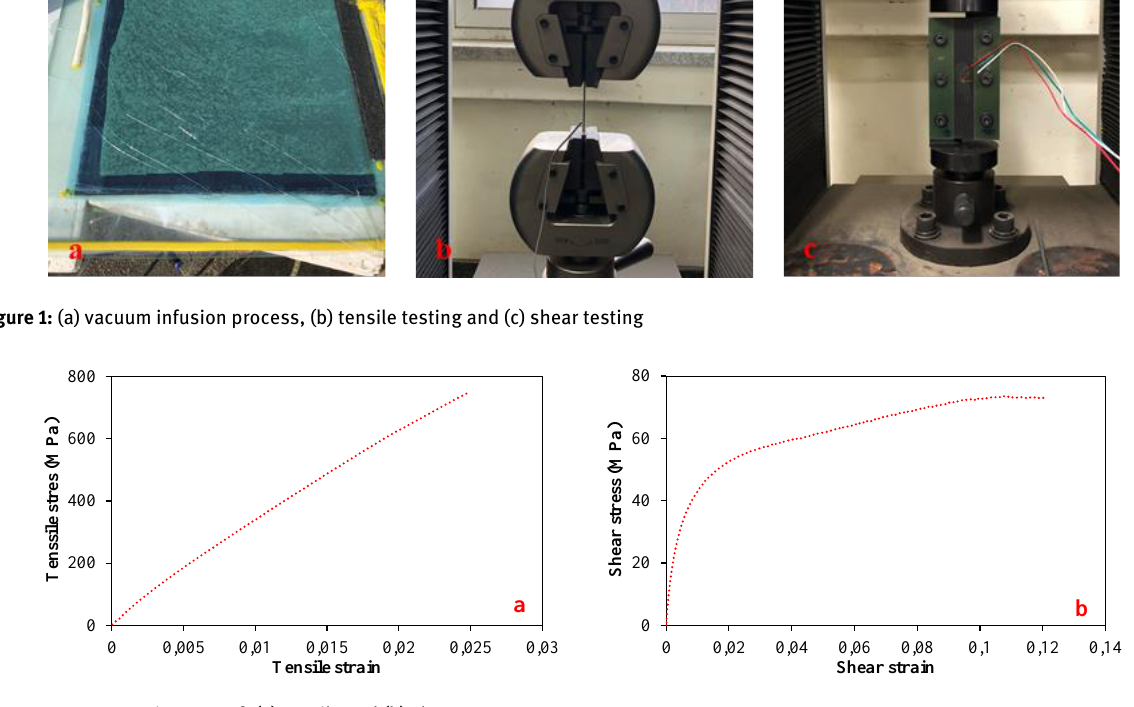
imens, strain gauges were glued at the center of the speci- mens for tensile and shear testing as shown in Figure 1(b) and 1(c), correspondingly.